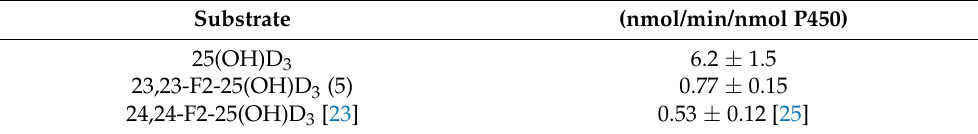
Table 1. Hydroxylation activities of human CYP24A1 toward 25(OH)D 3 ( 1 ) and 23,23-F 2 -25(OH)D 3 ( 5 ).